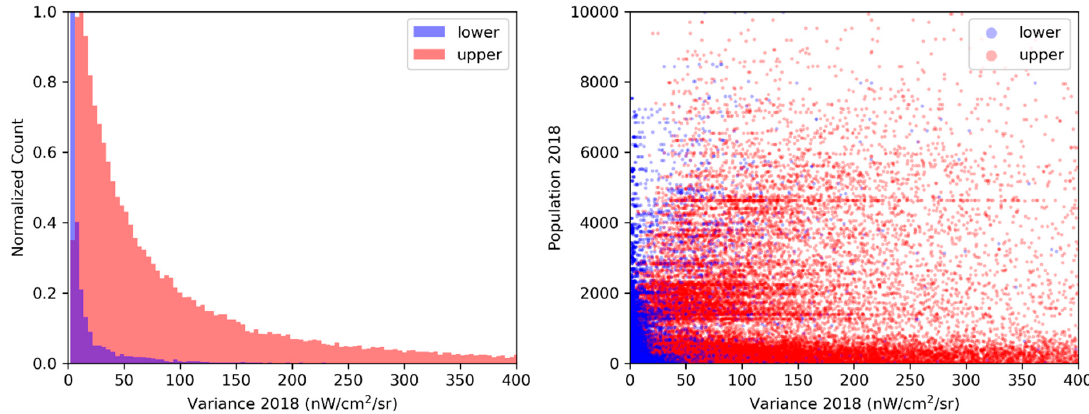
Figure 20. Histogram and scattergram of the 2018 variance values for the developing set (Harare, Dhaka, and Pyongyang) versus the developed set (Houston, Seoul, Shanghai, Beijing). The developed set is red and developing set is blue. The two sets are referred to as “lower” and “upper”, respectively. The sample set excludes grid cells deemed to be permanent background, where no lighting is detected. The scattergram is the variance versus population count from 2018.